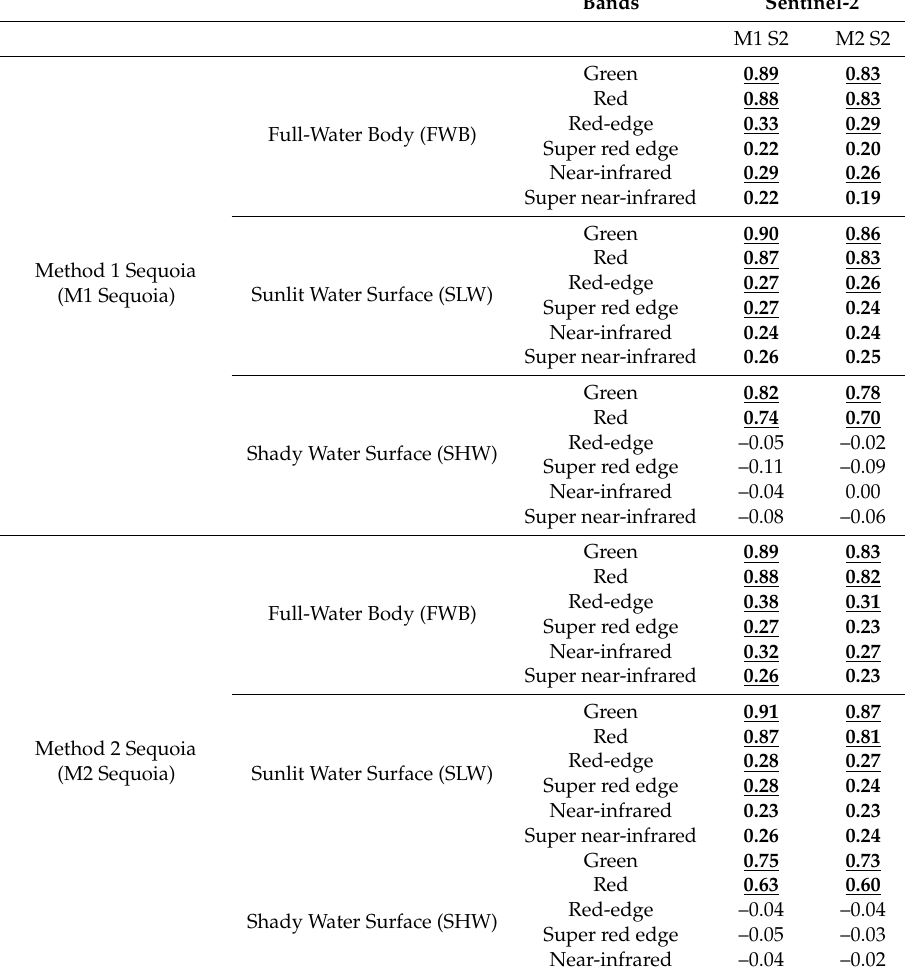
Figure 10. Reflectance of Parrot Sequoia (M2 S) and Sentinel-2 (M1 S2) for the full-water bodies. Table 2. Correlation between reflectance from the green, red, red-edge, super red edge, near-infrared and super near-infrared bands from the Parrot Sequoia survey, the Sentinel-2 scene. The values are Pearson correlation coefficients (R). Bold and underlined shows values significant at p ≤ 0.01. Bold shows values significant at p ≤ 0.05.